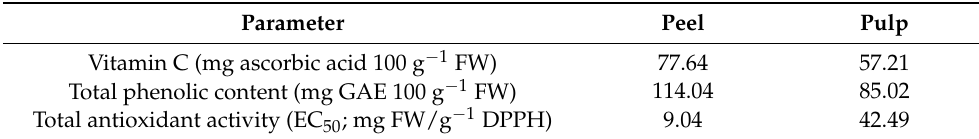
Table 2. Vitamin C content, total phenolic content, and total antioxidant activity of peel and pulp tissues of the feijoa